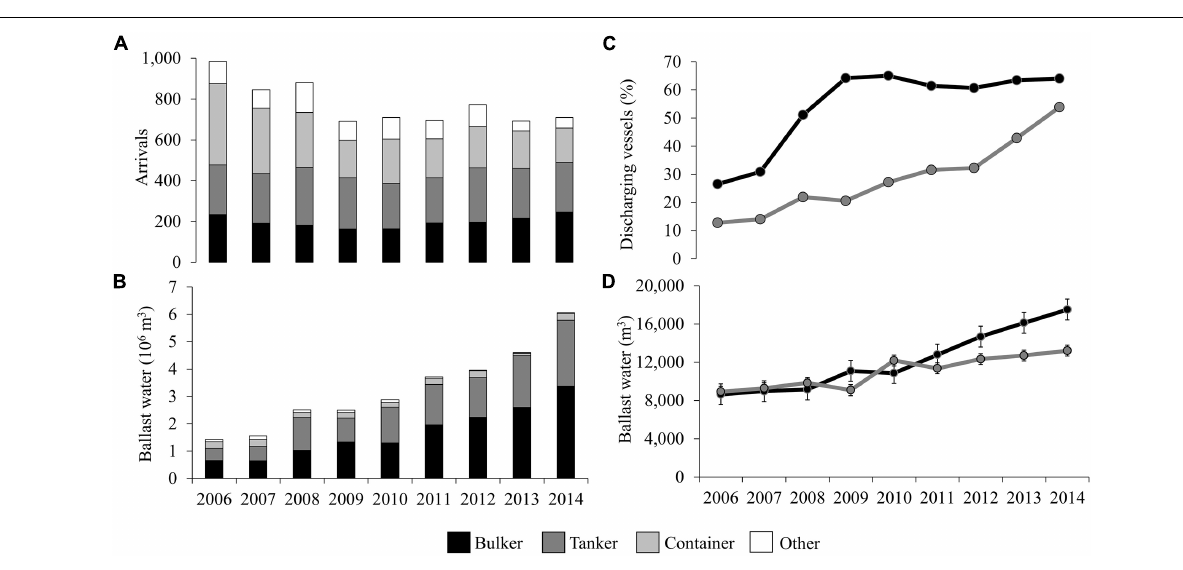
FIGURE 3 | Annual variation by vessel type for overseas (A) arrivals, (B) ballast water discharge, (C) percentage discharging arrivals, and (D) mean discharge volume of those vessels reporting discharge to San Francisco Bay. Error bars in panel (D) represent standard error. Panels (C,D) show growth in bulk carriers (bulkers) and tankers